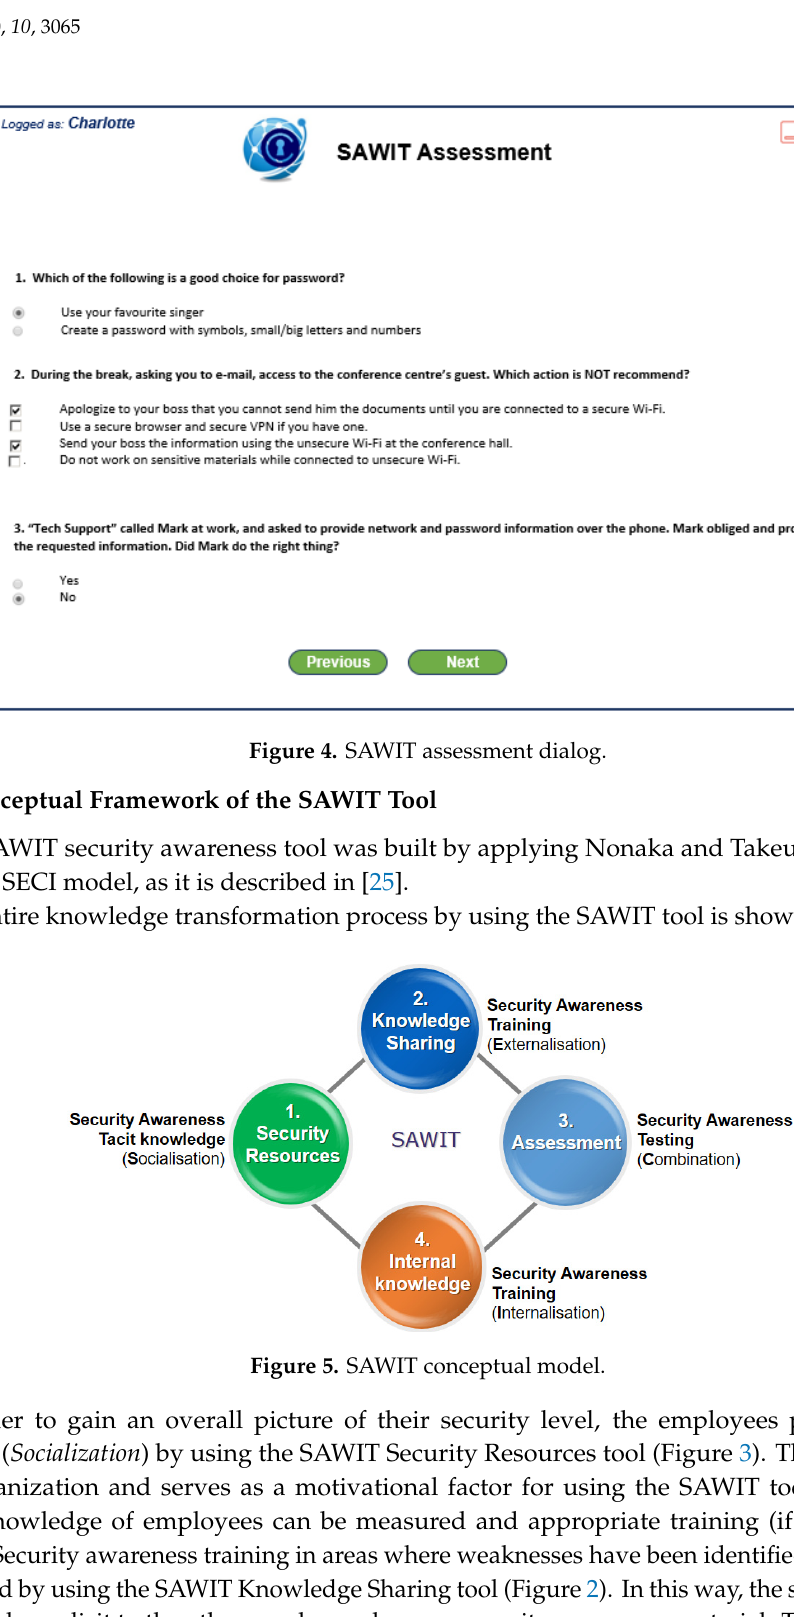
Figure 5. SAWIT conceptual model.